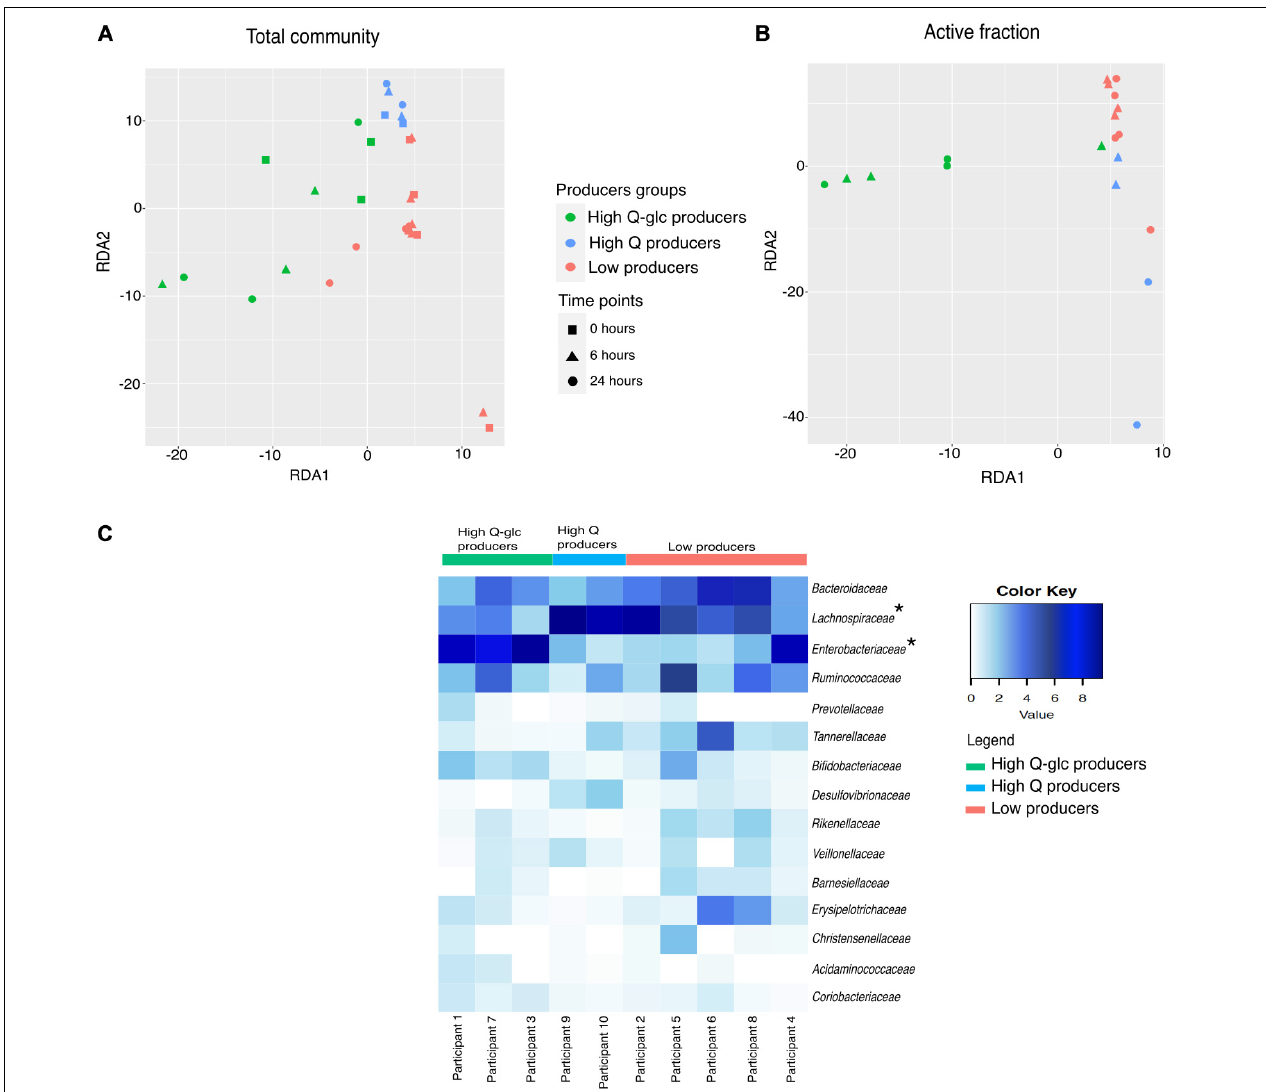
FIGURE 6 | Samples clusters based on rutin degradation pattern. Redundancy analysis shows sample clustering by degradation pattern in both the (A) total community [constrained variance explained:18.6%, RDA1 (14%), RDA2 (4.8%)] and (B) active fraction [constrained variance explained: 40.5%, RDA1 (36.3%), RDA2 (4.1%)]. (C) Family-level heatmap showing the square root transformed relative abundance of the active fraction divided by producer groups at 24 h. Significant changes in relative abundance (Low producers vs. High producers) are indicated with asterisks. Enterobacteriaceae increased in relative abundance in the High Q-glc producers. (High Q-glc producers vs. Low producers, p = 0.0055, High Q-glc producers vs. High-Q producers, p = 0.0061). Lachnospiraceae increased in relative abundance in the high-Q producers (High-Q producers vs. Low producers, p = 0.0043, High-Q producers vs. High Q-glc producers, p < 0.00001).